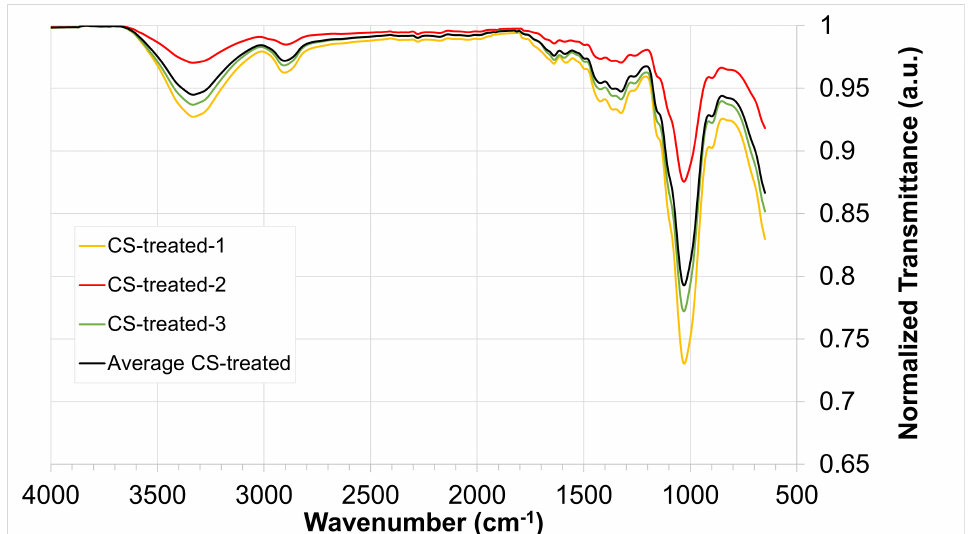
Figure 2. FTIR profiles of corn stover pretreated with recovered solution from CO 2 absorption column. Samples presented were ran in triplicates and